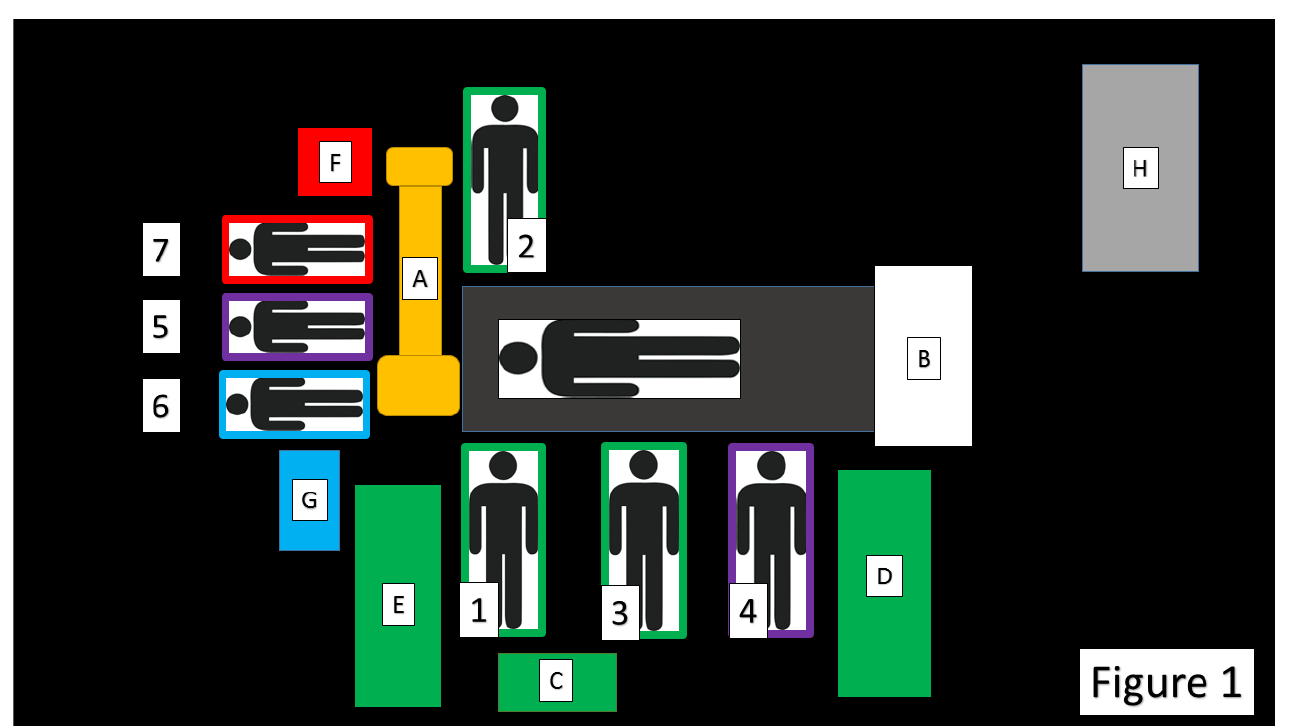
Fig. 1 - Schematic panel of the hybrid operating room setting for transaortic transcatheter aortic valve replacement (TAVR). The C-arm (A) is classically oriented as per transfemoral TAVRs, but the screen is moved to the patients’ feet (B). First operator, assistant, and eventually third operator (1, 2, and 3) are located in a standard surgical position. We routinely utilize three tables (C, D, and E) for valve preparation, surgical, and percutaneous instruments, respectively. The latter table is also useful for harboring the prepared delivery system. The nurses are at the right side of the operator (4) and at the head of the patient (5). The anesthetist (6) and, if needed, the cardiologist with an echocardiographer (7) are at the right head-side and left-head side of the patient, respectively. A running cardiopulmonary bypass (H) is present at the entrance of the operating room. F is the echo